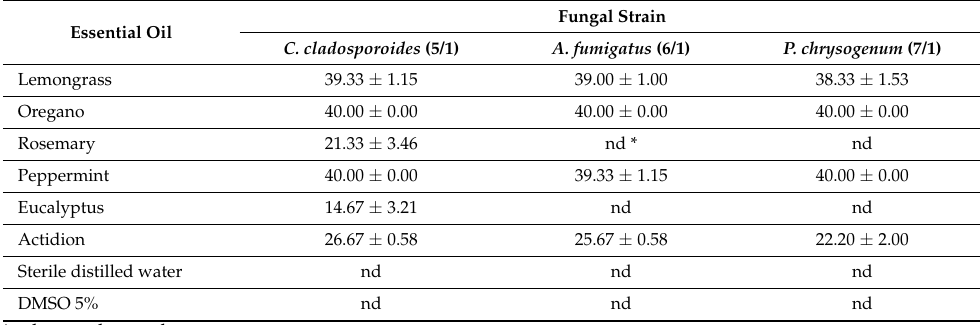
Table 1. Inhibition zones (mean value diameter (mm) ± standard deviation) observed on Sabouraud Dextrose Agar.